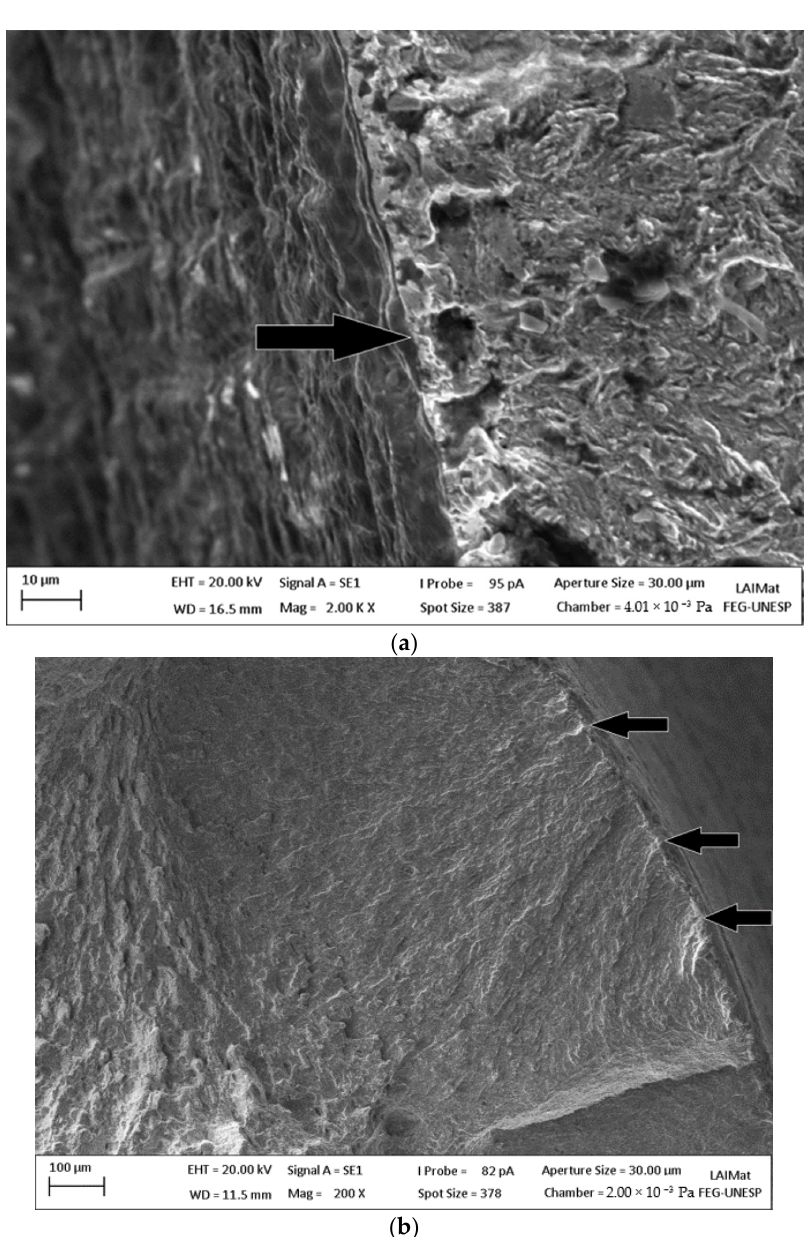
Figure 20. Fractography of Cd-coated standard specimen tested at a maximum stress of ( a ) 749 MPa (2.06 × 10 5 cycles) and ( b ) 837 MPa (3.2 × 10 4 cycles).